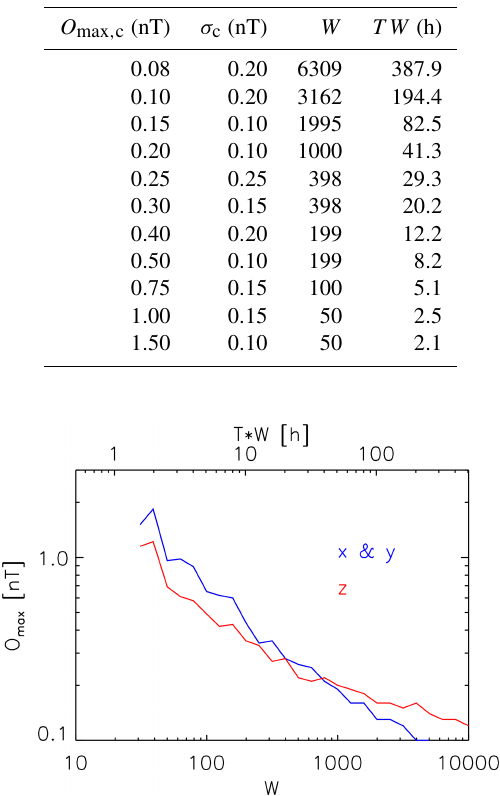
Figure 5. Offset uncertainties O max ,xy (blue) and O max ,z (red) as a function of W or T W for fixed σ c = 0 .